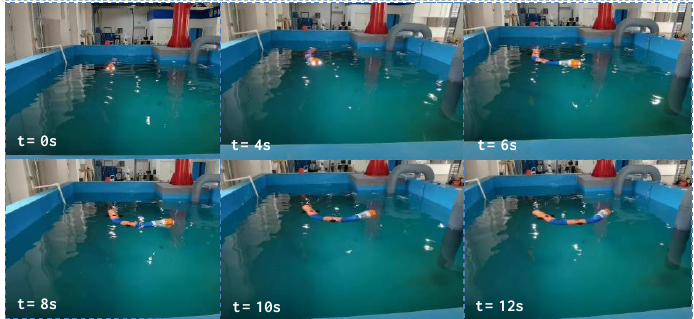
Figure 9. Test results of horizontal turning motion of the robot.